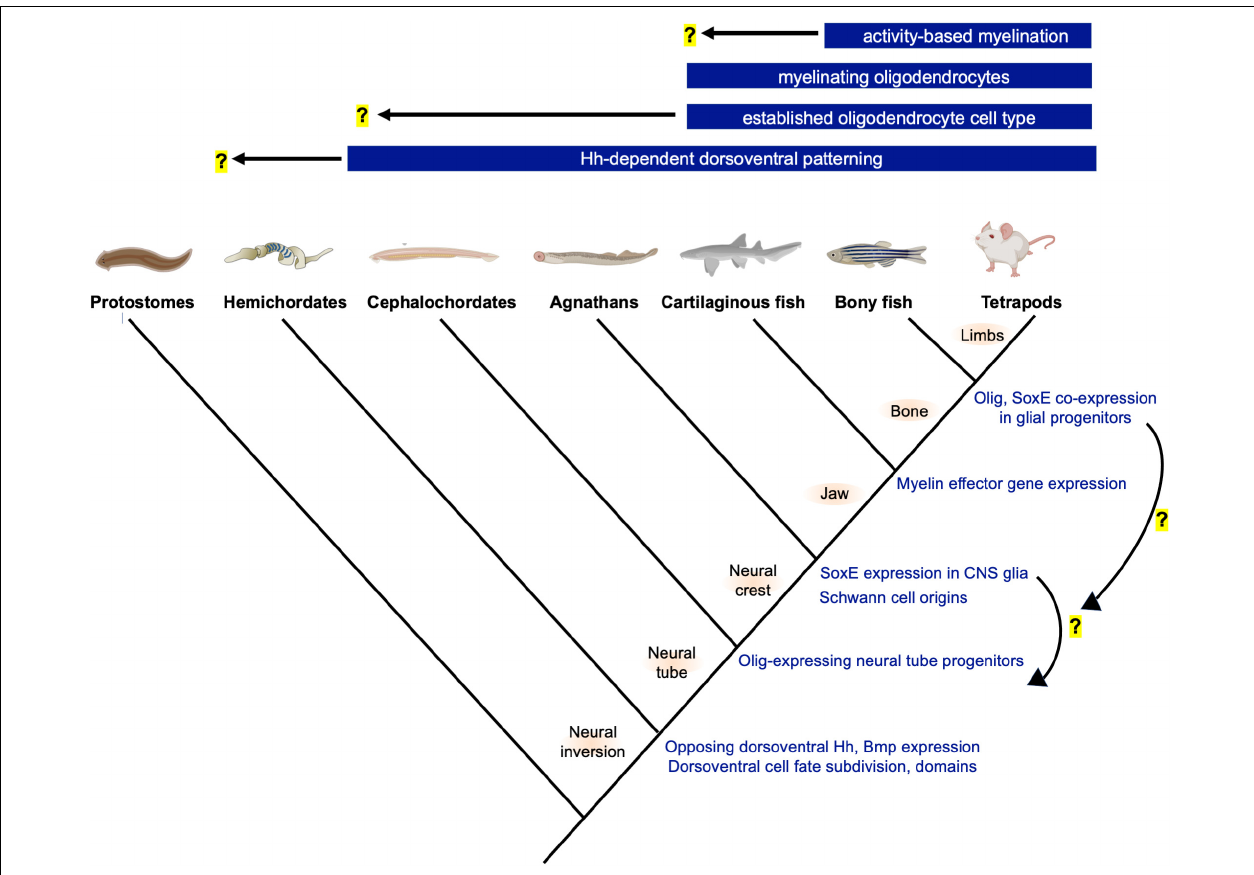
FIGURE 1 | Phylogeny and innovations related to neural tube patterning and the evolution of oligodendrocytes. Top bars show the earliest known origins for novelties related to oligodendrogenesis and myelination. Hemichordates and cephalochordates such as acorn worms and amphioxus show similarities in neural tube dorsoventral patterning and progenitor domain subdivision. Future studies are needed, but the gradual changes to oligodendrocyte-associated gene expression (right, blue font) suggest step-wise GRN assembly and raise the possibility that the oligodendrocyte cell type preceded the evolution of the myelinating phenotype. Illustration generated using BioRender